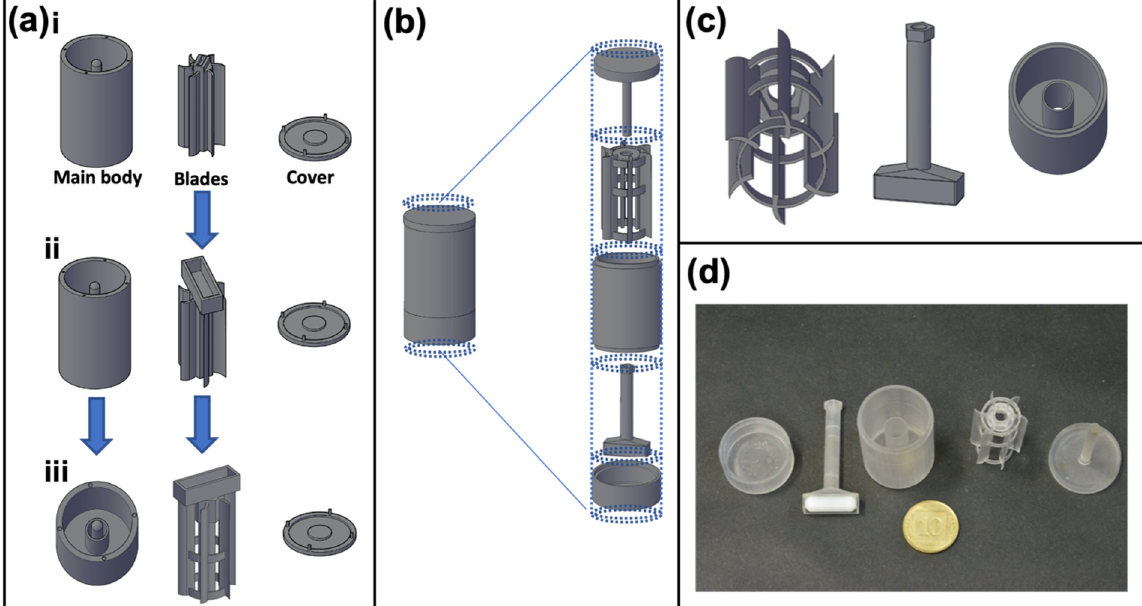
Figure 1. Evolution of the 3DCFS design. The purpose of the 3DCFS is to obtain a continuous and uniform stirring of cells and medium over time. ( a–b) Changes made to the design (depicted in AutoCAD). a.i “Magnet above” includes three parts: main body with a central hinge, blades with magnet pocket and cover. a.ii Enlarging the magnet pocket. a.iii Adding an internal cylinder and reshaping the blades to prevent fluids from wetting the central pole and interfering with the blades’ movements. “Magnet below” includes five parts (top to bottom): ( b–c ) cover with a central hinge, blades, main body, magnet holder and a bas, that all fit together and move as one unit. ( d ) Photograph of the final 3D printed 3DCFS parts.